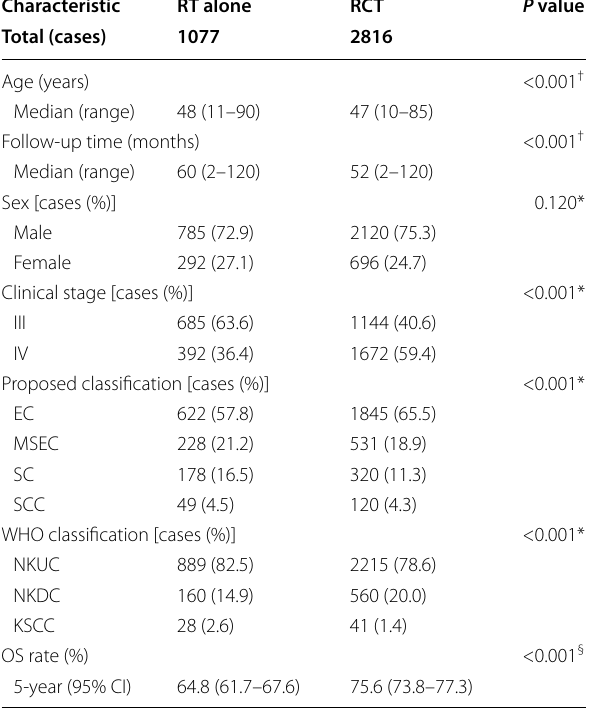
Table 5 Clinical characteristics of 3893